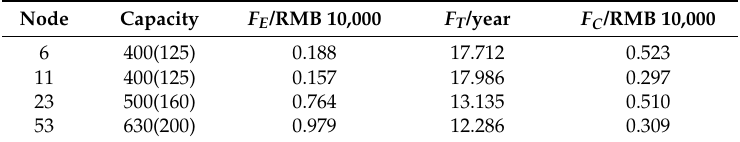
Table 6. Cost benefit indexes of replacing with on-load capacity regulating distribution transformers.